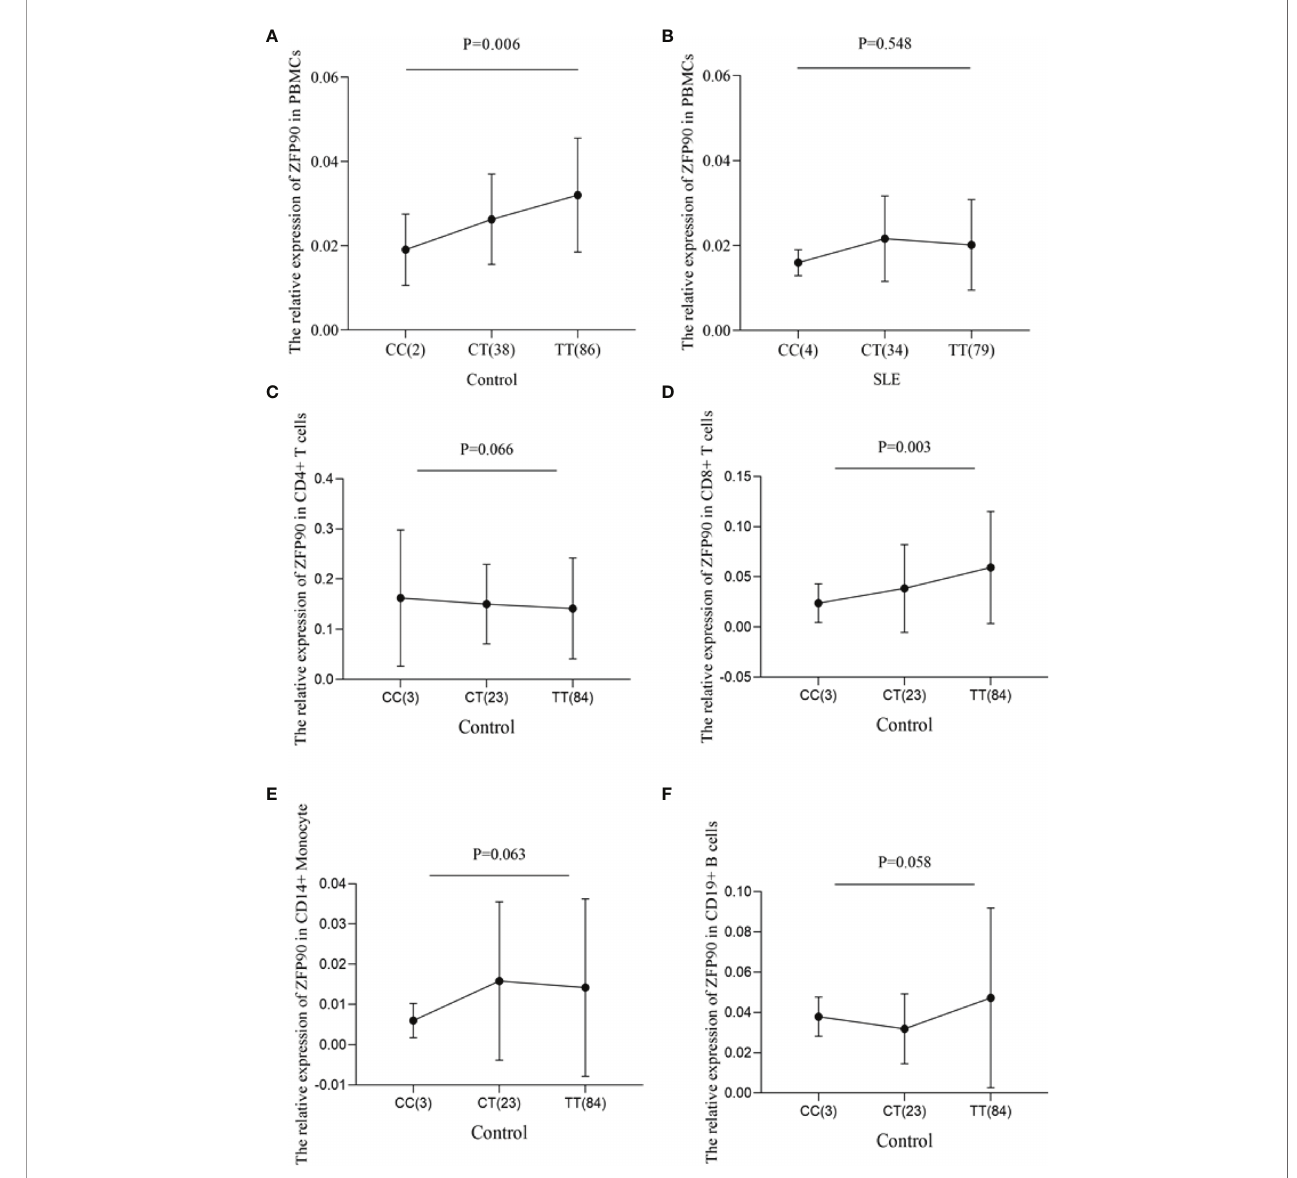
FIGURE 1 | (A) The effect of rs1170426 on ZFP90 mRNA expression levels in PBMCs from healthy controls. Of the 126 controls, 2 individuals with CC, 38 with CT, and 86 with TT were analyzed. The group with “ CC ” homozygous has the lowest expression levels ( P = 0.006). (B) The effect of rs1170426 on ZFP90 mRNA expression levels in PBMCs from SLE cases. Of the 117 cases, 4 individuals with CC, 34 with CT, and 79 with TT were analyzed. The expression did not signi fi cantly correlate with genotype of rs1170426 ( P = 0.548). (C – F) The effect of rs1170426 on ZFP90 mRNA expression levels in CD4+ T cells, CD8+ T cells, CD19+ B cells, and CD14+ monocytes from other 110 healthy controls. Of the 110 controls, 3 individuals with CC, 23 with CT, and 84 with TT were analyzed. ZFP90 expression levels of samples with risk allele “ C ” of rs1170426 were signi fi cantly decreased in CD8+ T cells ( P = 0.003).